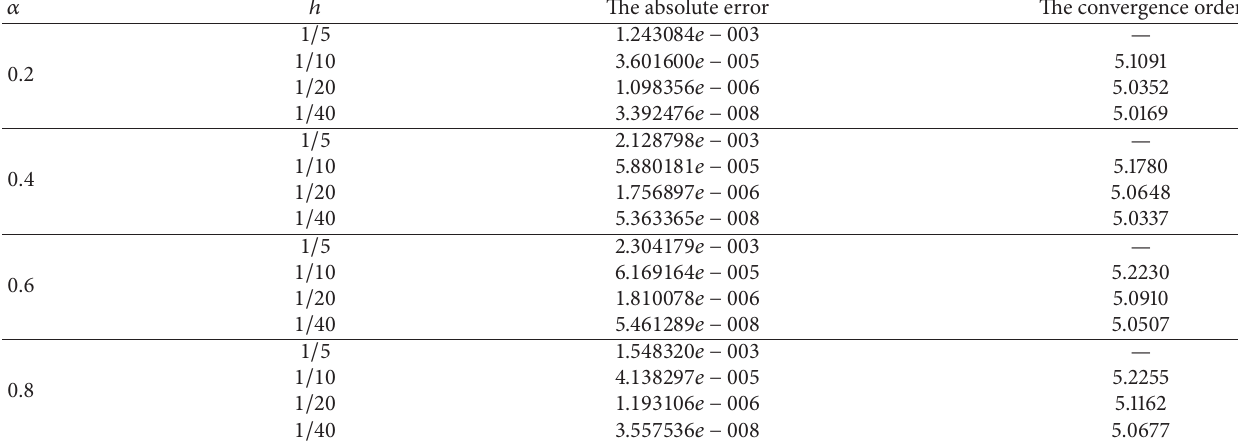
Table 3: The numerical results of the Example 8 with 𝑞 = 5 by formula (14) with 𝑝 = 5